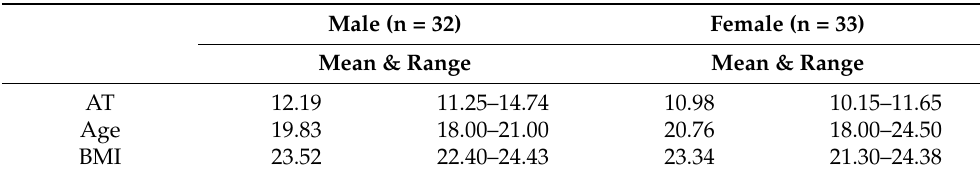
Table 1. Baseline characteristics of professional athletes (n = 65).